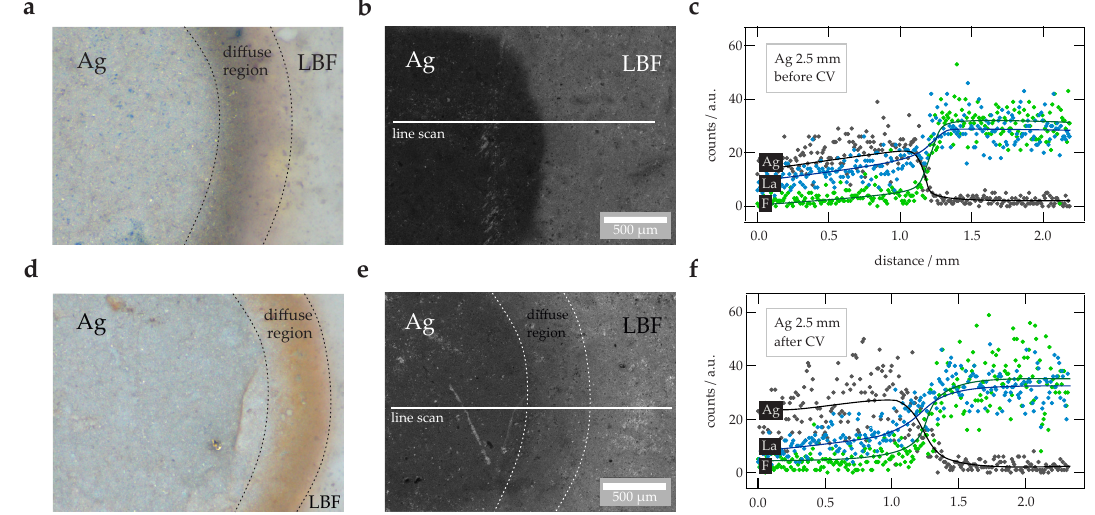
Figure 3. ( a ) Images acquired by digital light microscopy of a sample pellet with Ag as working electrode ( d = 2.5 mm) before the cyclic voltammetry (CV) measurements have been carried out. ( b ) SEM image (secondary electron (SE) detector) of this pellet before CV. The horizontal line indicates the run of the energy dispersive X-ray spectroscopy (EDX) line scan. ( c ) EDX line scan across the surface of the pellet, as depicted in ( b ), for the elements F, Ag and La. The lines are only a guide for the eye. ( d ) Image obtained via digital light microscopy of a sample pellet with Ag working electrode after CV. ( e ) SEM image (SE detector) of the sample pellet with Ag as working electrode, the image was taken after the CV measurements. The horizontal line indicates the run of the (EDX) line scan. ( f ) EDX line scan across the surface of the pellet, as depicted in (b), for the elements F, Ag and La, respectively The lines are drawn to guide the